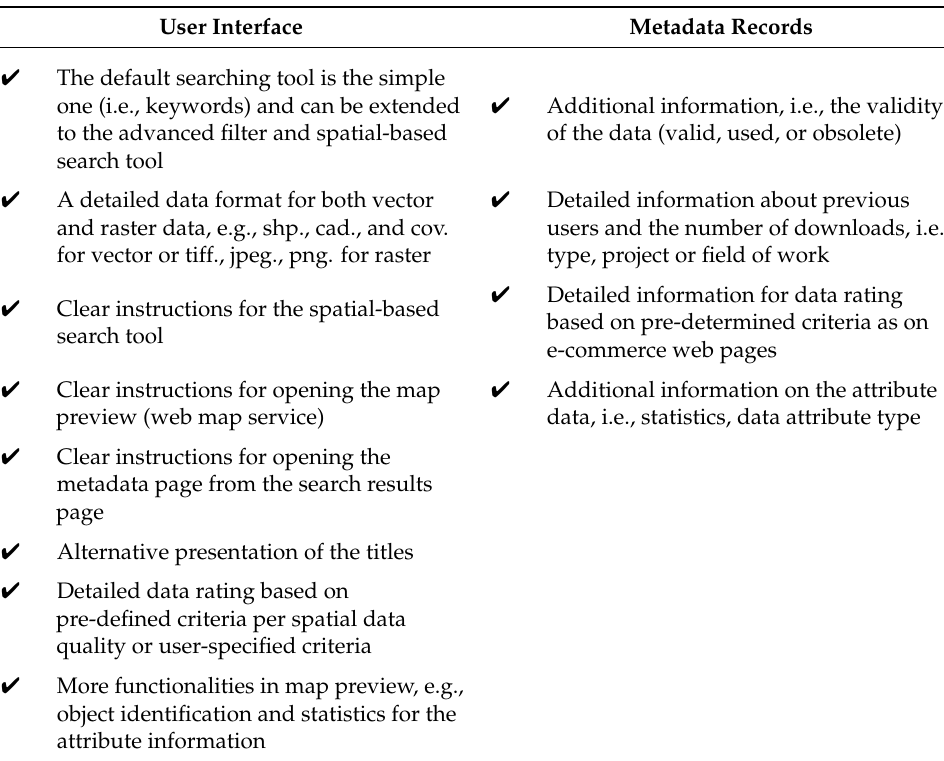
Table 1. User feedback on the